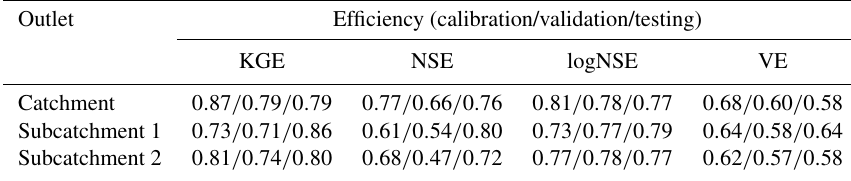
Table 6. Performance matrix of MIKA-SHA_FUSE.